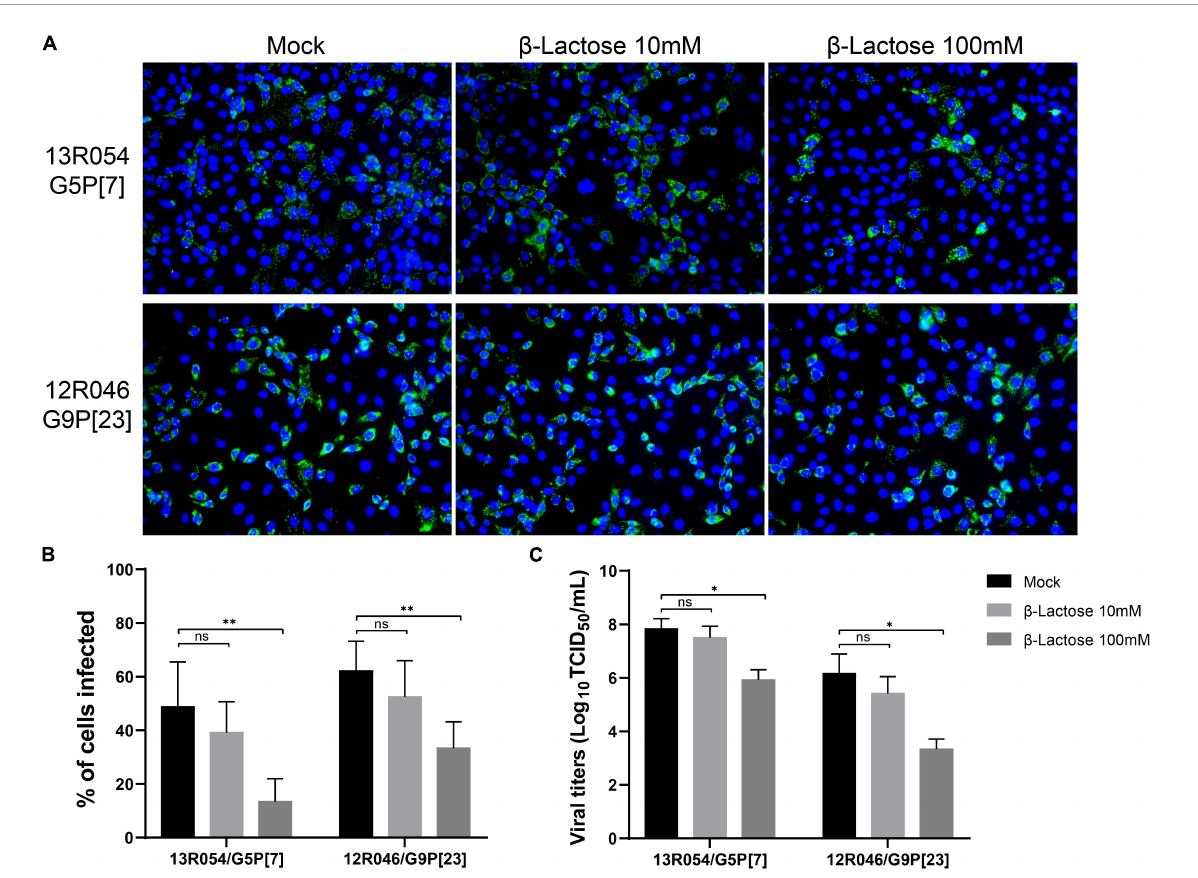
FIGURE6 The infection of MA104 cells by the porcine RVA strains 13R054 G5P[7] and 12R046 G9P[23] is strongly reduced by β -lactose. (A) The effects of pre-incubation of the virus with β -lactose on the infectivity of the porcine RVAs 13R054 G5P[7] and 12R046 G9P[23] were assessed using an immunofluorescence assay with polyclonal antibodies against the RVA VP6 protein. (B) The infection of MA104 cells with both RVA strains was expressed as percentage of infected cells and compared with the mock-treated, virus-inoculated control. (C) The titration of the supernatant was performed on MA104 cells. All experiments were performed in three independent experiments. Error bars in the panel represent the means ± the SD from triplicate experiments. ∗∗ , P < 0.01. ∗ , P < 0.05. ns, P > 0.05.